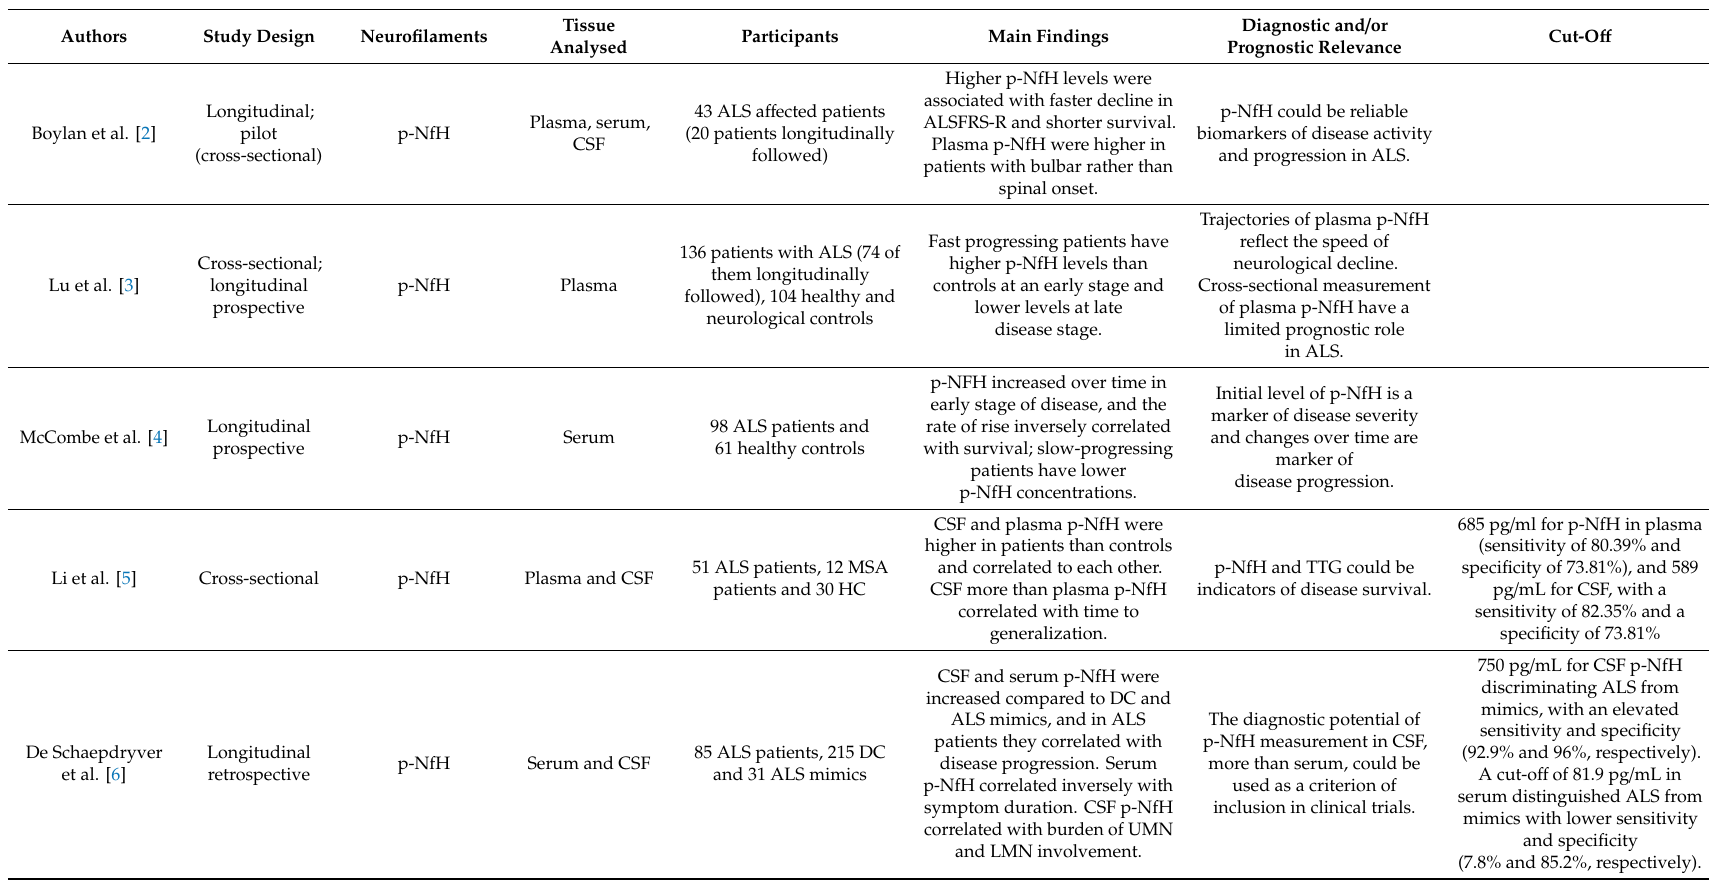
Table 1. Neurofilament studies in amyotrophic lateral sclerosis. The most relevant studies about neurofilaments (Nfs) in Amyotrophic lateral sclerosis (ALS). For each study, we reported the first author, the study design, the subtype of Nf analyzed (phosphorylated heavy chain and light chain Nfs, or both), the biological fluid analyzed (plasma, serum or cerebrospinal fluid), the features of the participants, the main findings of the study, the diagnostic and prognostic relevance of the studies, and when available, the cut-o ff level of Nfs able to discriminate patients from